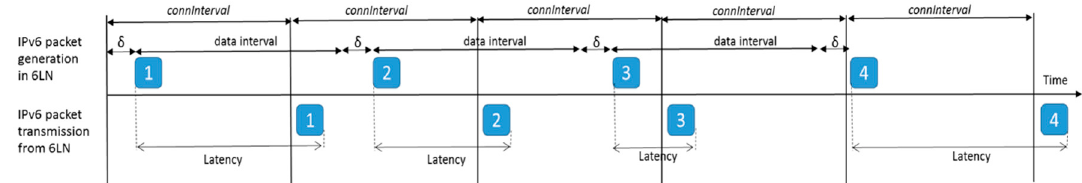
Figure 5. Time diagram for an example that illustrates one-hop IPv6 packet latency when the sender (the 6LN in our testbed) is also the packet source (for connInterval = data interval). In the example, four packets are transmitted (the packets are identified by numbers 1, 2, 3 and 4).